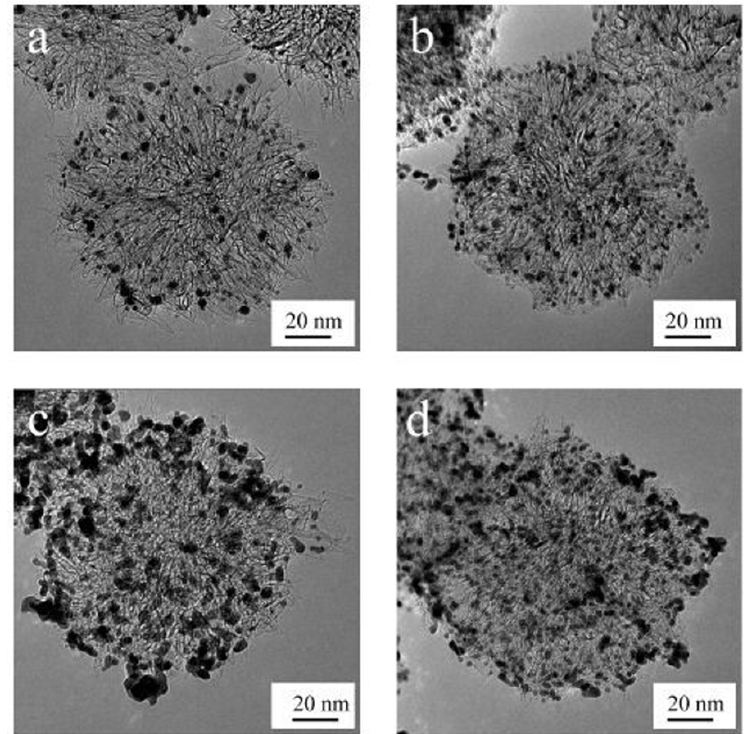
Figure 1. Transmission electron microscope (TEM) images of the supported catalyst: ( a ) 20 wt % Pt on as-grown single-walled carbon nanohorns (SWCNHs); ( b ) 20 wt % Pt on treated-SWCNHs; ( c ) 60 wt % Pt on as-grown SWCNHs; ( d ) 60 wt % Pt on treated SWCNHs. Reproduced with permission of [29]; American Chemical Society,